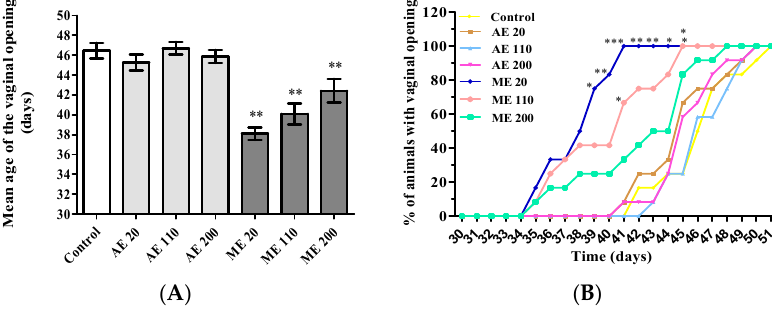
Figure 1. Mean age ( A ) and percentage ( B ) of animals with vaginal aperture. Control = animals receiving vehicle (distilled water, 10 mL/kg BW); AE = animals treated with the aqueous extract of M. arboreus ; ME = Animal treated with the methanol extract of M. arboreus . Results are shown as the mean ± SEM.; *: p < 0.05; **: p < 0.01; ***: p < 0.001 in reference to control.